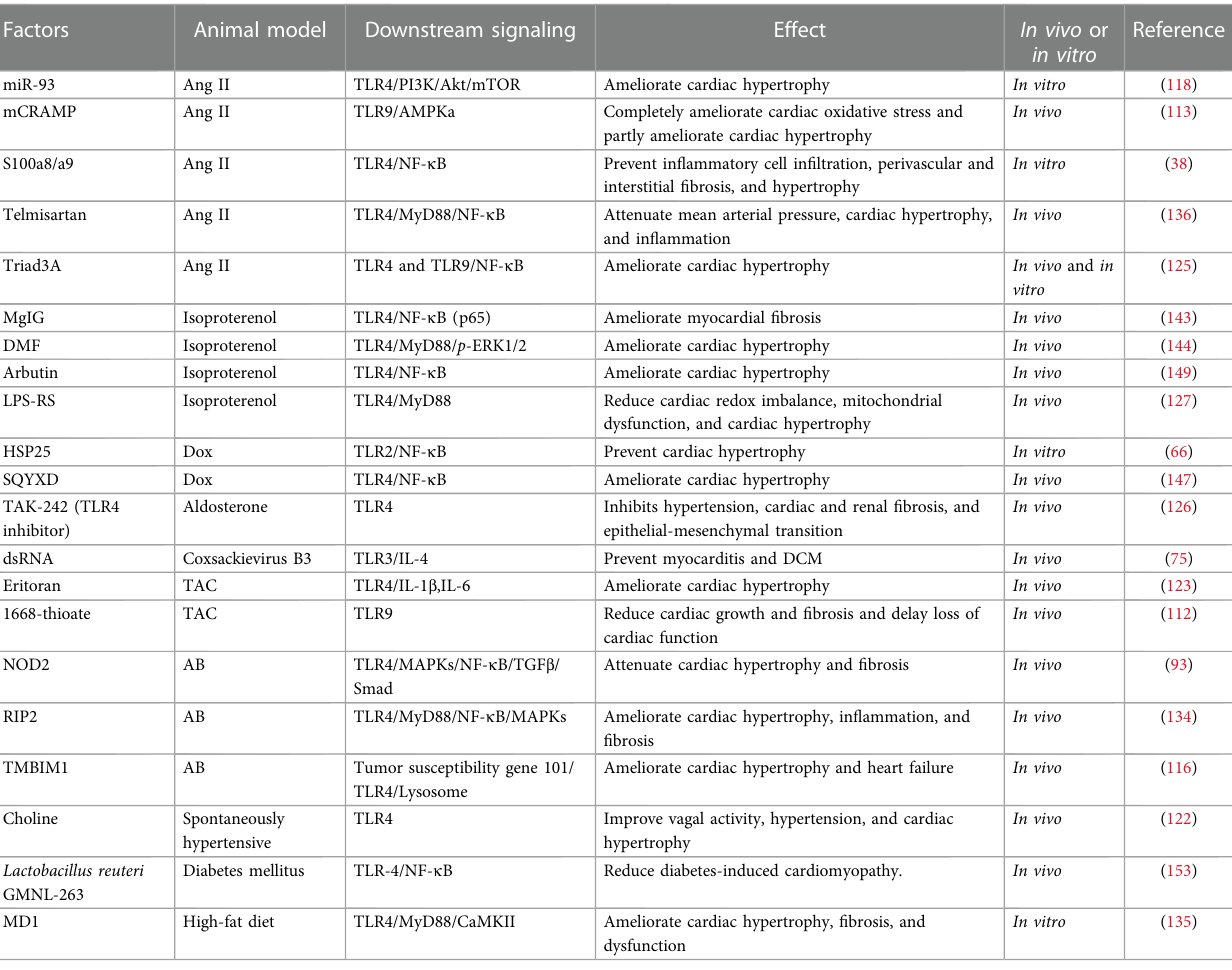
TABLE 2 Summary of various inhibitors that can interact with TLR signaling and ameliorate cardiac hypertrophy and cardiac remodeling.